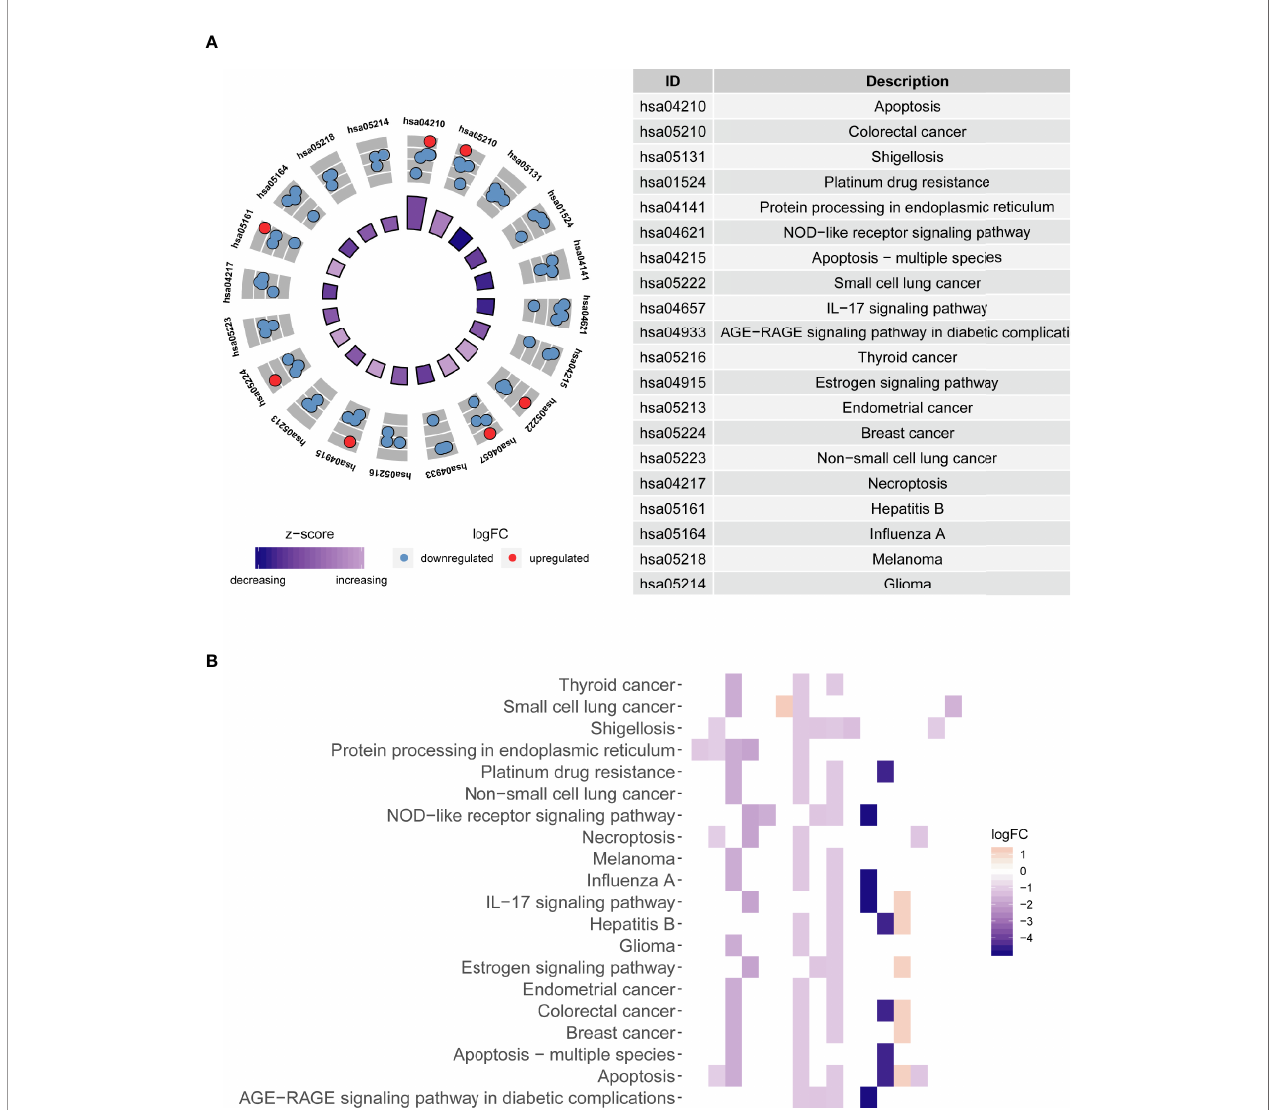
FIGURE 5 | Kyoto Encyclopedia of Genes and Genomes (KEGG) pathway enrichment analysis of differentially expressed autophagy-related genes (ARGs). (A) The circle shows a scatter plot for each term of the logFC of the assigned genes. The red circles represent upregulation, and the blue circles represent downregulation. (B) Heatmap of the relationship between ARGs and pathways. The color of each block depends upon the values of